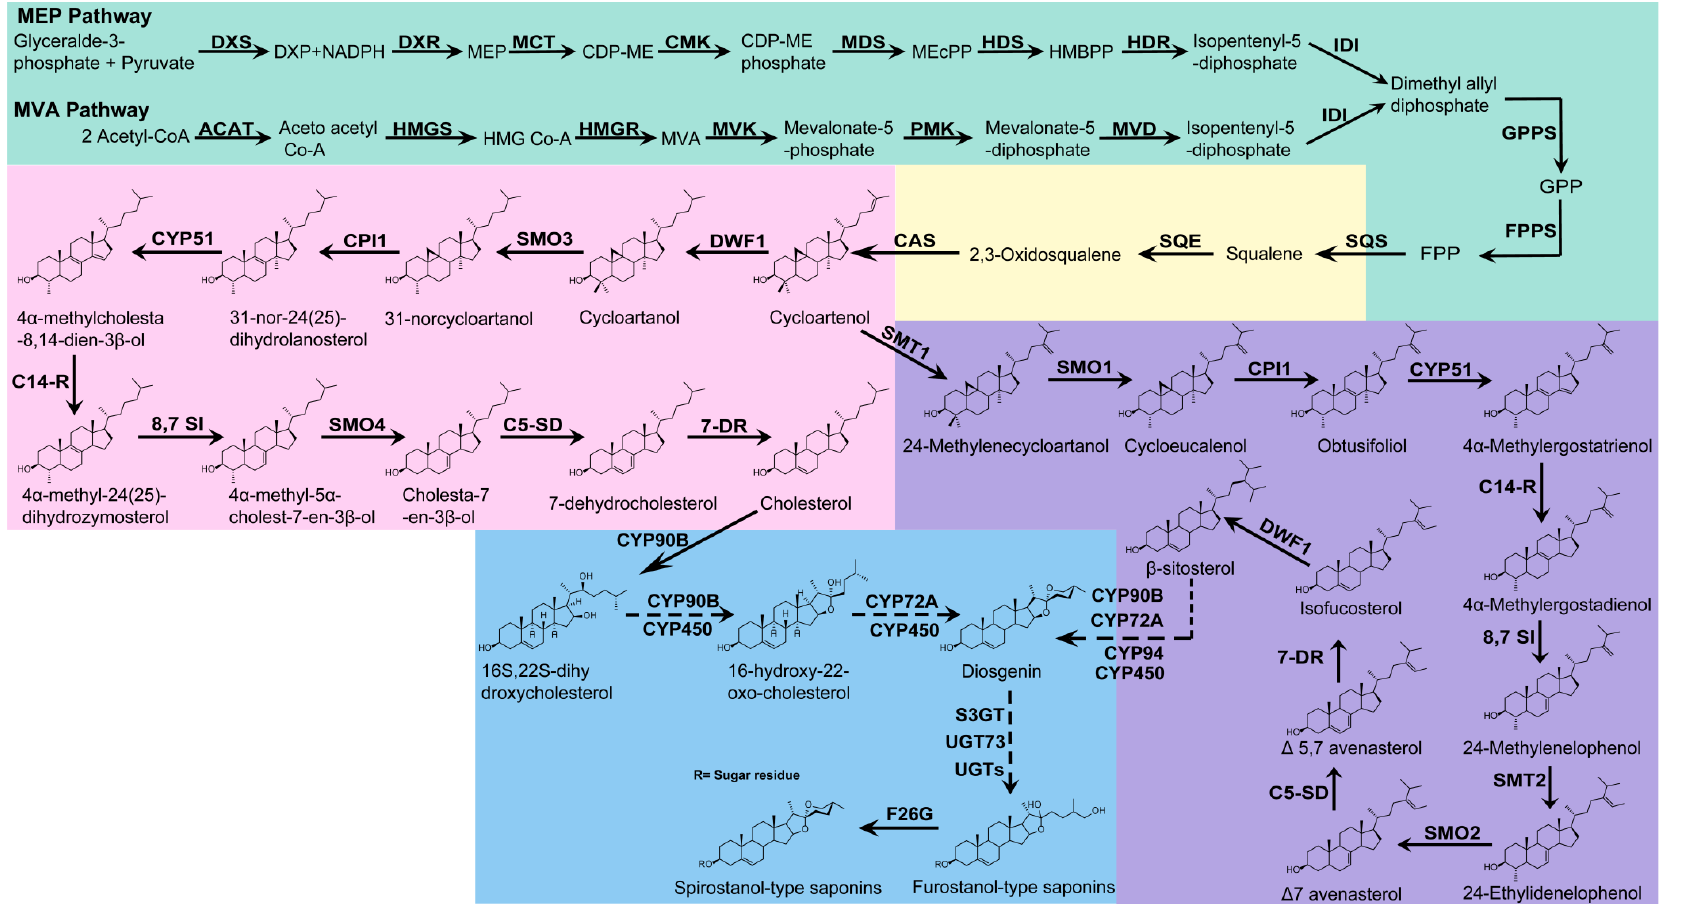
Figure 2. Possible biosynthetic pathways of steroidal saponins in plants. Biosynthetic pathway of 2,3-oxysqualene (light green); squalene is catalyzed by SQE to form 2, 3-oxide squalene (light yellow), which is also the demarcation point between sterol and triterpene metabolism. The biosynthetic pathway of cholesterol and β -sitosterol are depicted in pink and purple, respectively. The biosynthetic pathway of steroidal saponins is marked in blue. Dashed arrows indicate that there may be multiple catalytic